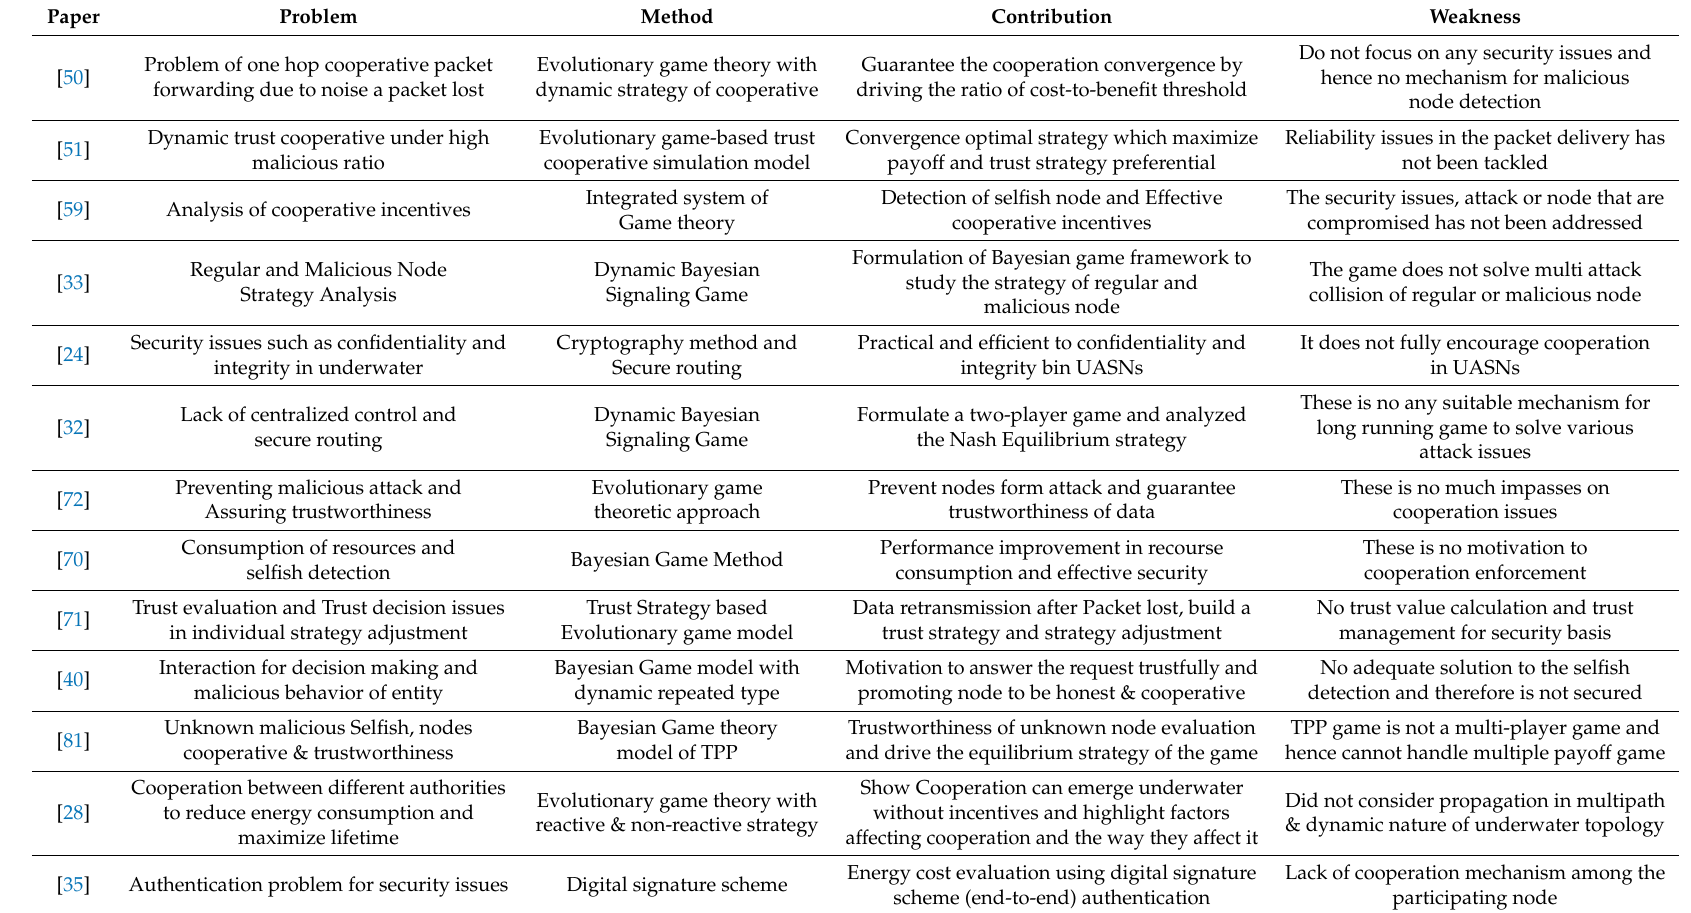
Table 2. Summary of cooperative game methods in